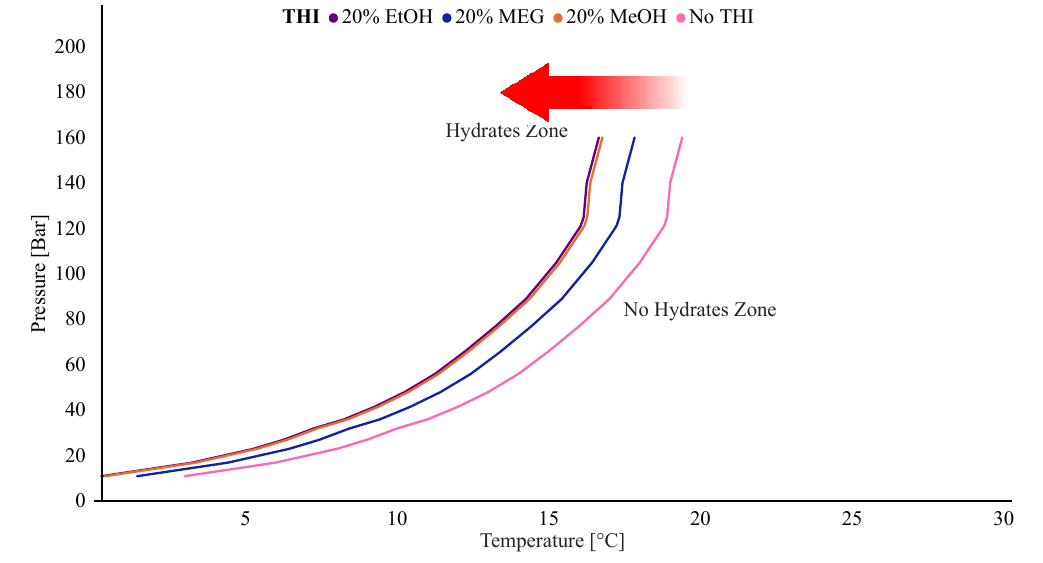
Figure 2. Hydrate formation zones shift caused by the use of 20% of THI—Adapted from Kim (2018) [10]. The No THI hydrate curve was adapted from Kim (2018) [10]. The composition of the fluid can be found in Kim (2018) [10]. The curves considering 20% of THI were calculated using the Hammerschmidt method, Equation (1). The data for these curves can be found in Table A1. Figure 2 demonstrates the effect of the THI decreasing the temperature and shifting the curves. In this case, we used a 20 wt% of mentioned THI. Hammerschmidt Equation as is shown in Equation (1) [11].